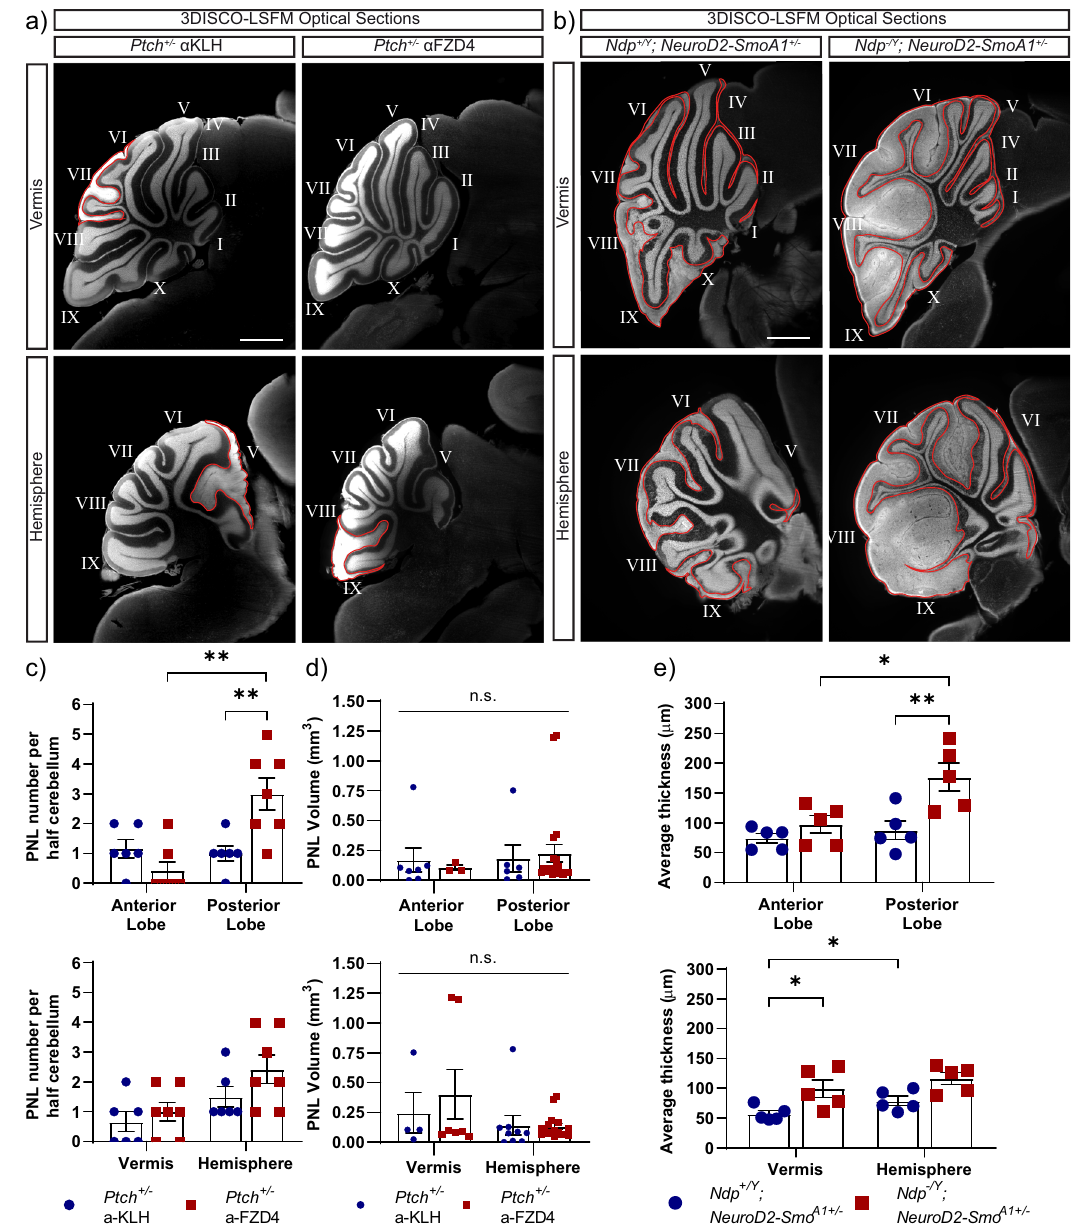
Fig. 4 Spatially restricted effects of Norrin/Fzd4 signalling on preneoplasia in Neurod2-SmoA1 + / − mice. Representative TO-PRO-3 stained (white) optical sections of cerebella of Ptch + / − mice treated with α Fzd4 and α KLH antibodies ( a ) and Ndp + /Y ; Neurod2-Smo A1 + / − and Ndp − /Y ; Neurod2-Smo A1 + / − mice at P14 ( b ) comparing the vermis and hemisphere regions. PNLs ( Ptch + / − ) and EGL hyperplasia ( Neurod2-Smo A1 + / − ) are outlined in red. Lobules of the cerebellum are labelled from I to X along the rostral-caudal axis. Number of PNLs and PNL volume in Ptch + / − mice ( c , d ) and average EGL thickness in Neurod2-Smo A1 + / − mice ( e ) as a function of position. c PNL number is signi fi cantly increased in the posterior lobe in α Fzd4-treated Ptch + / − mice ( n = 7 mice, α Fzd4; n = 6 mice, α KLH) when compared to the anterior lobe of α Fzd4-treated Ptch + / − ( p = 0.045) or the posterior lobe of α KLH-treated Ptch + / − mice ( p = 0.024), ** p < 0.01, (Two-way ANOVA). d There was no spatially restricted effect on PNL volume ( n = 4, Ptch + / − α KLH, vermis; n = 7, Ptch + / − α Fzd4, vermis; n = 9, Ptch + / − α KLH, hemisphere; n = 17, Ptch + / − α Fzd4, hemisphere), n.s. p > 0.05 (Two-way ANOVA); ( n = 7, Ptch + / − α KLH, anterior lobe; n = 3, Ptch + / − α Fzd4, anterior lobe; n = 6, Ptch + / − α KLH, posterior lobe; n = 21, Ptch + / − α Fzd4, posterior lobe), n.s. p > 0.05 (two-way ANOVA). e EGL thickness was signi fi cantly increased in the posterior lobe ( p = 0.029) and vermis ( p = 0.0164) in Ndp − /Y ; Neurod2-Smo A1 + / − mice ( n = 4